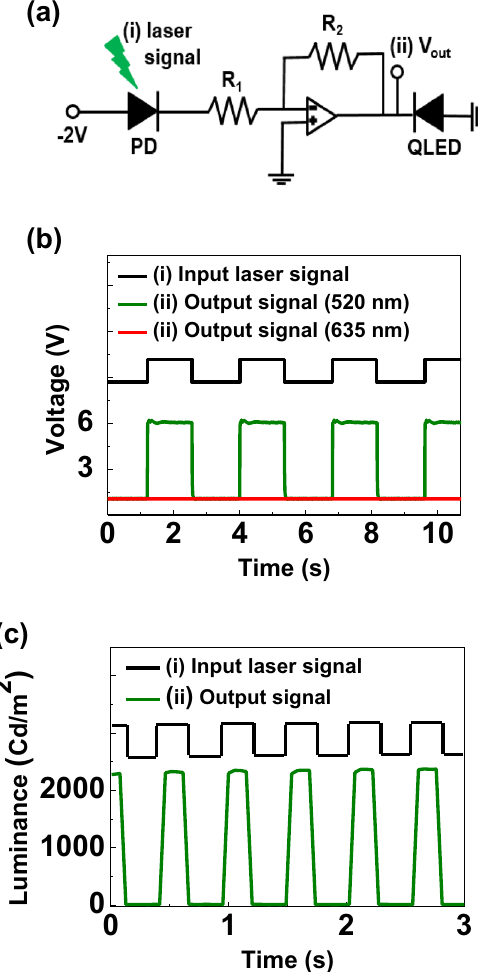
Figure 6. ( a ) Circuit diagram that used two dual-functional QLEDs. Input laser signal enables to produce enough electrical signal from the first device (PD) to turn-on the second device (QLEDs) for the light emission. ( b ) Periodic photoresponses of the PD according to the 520 and 635 nm wavelength light signal measured at (ii) V out of the circuit diagram. ( c ) Luminescence characteristics of the QLEDs according to the periodic input laser signal (λ = 520 nm) into the